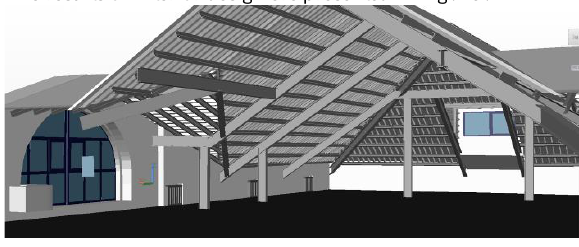
Figure 13 . 3D modeling and design of the interior.